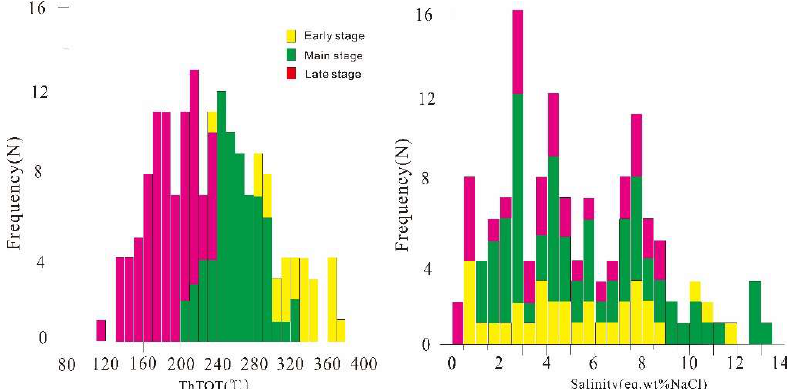
Figure 6. Histograms of microthermometric data showing temperatures of ( a ) Th TOT and ( b ) salinity.